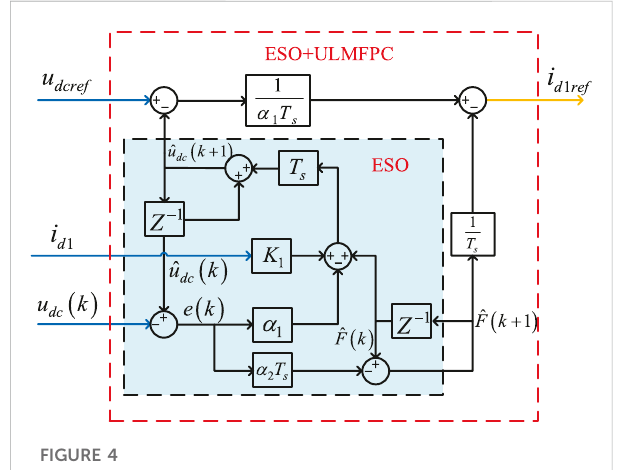
Block diagram of outer-loop ESO-based ULMFPC.